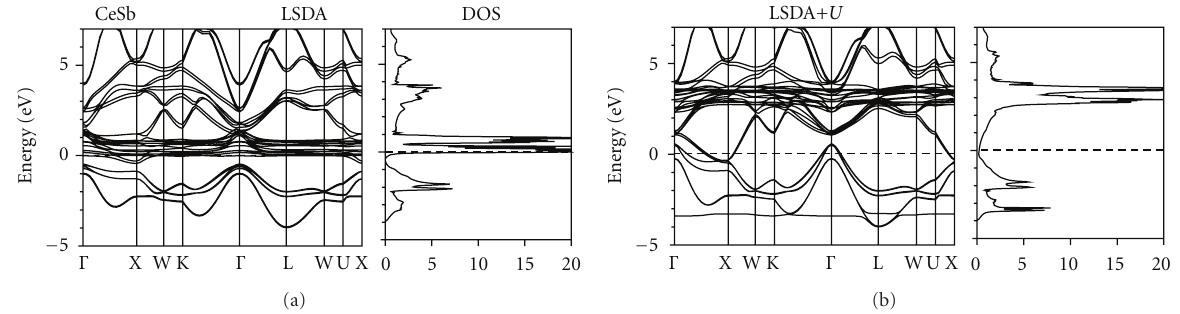
Figure 41: Self-consistent fully relativistic, spin-polarized energy band structure and total DOS (in states/(unit cell eV)) calculated for CeSb in the LSDA and LSDA+ U ( U e ff = 6eV) approximations